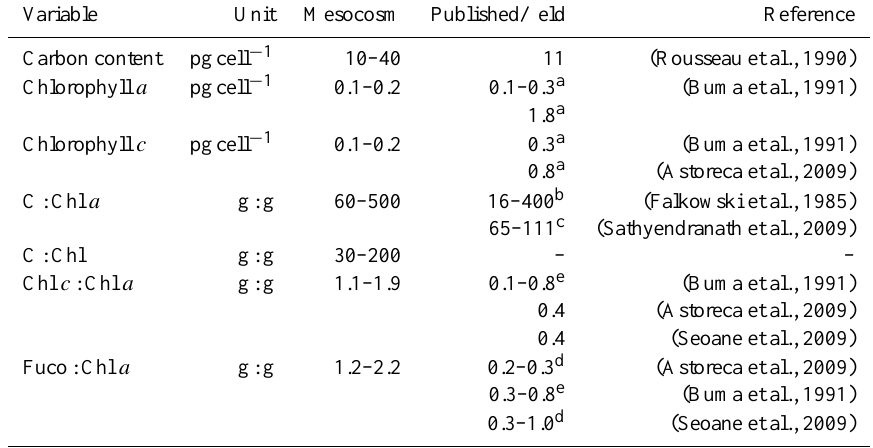
Table 5. Biochemical characteristics of Phaeocystis in the mesocosm compared to published data from cultures, unless otherwise indicated. Chl is the sum of chlorophyll a and c ; Fuco: